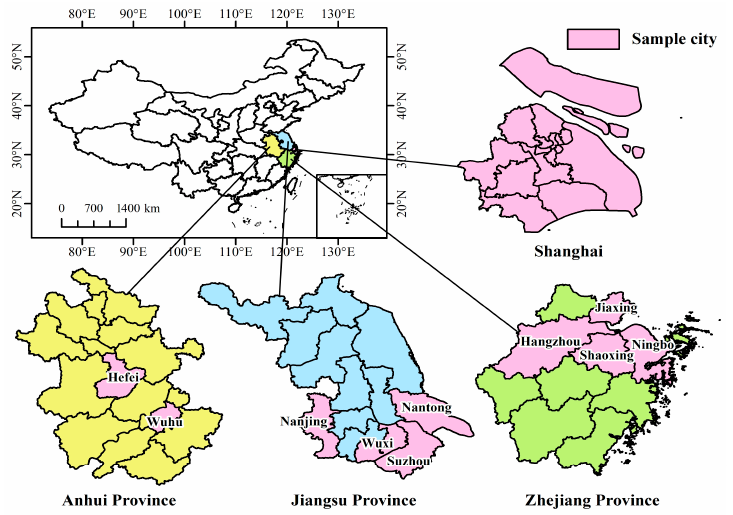
Figure 1. Geographical maps of the Yangtze River Delta region.